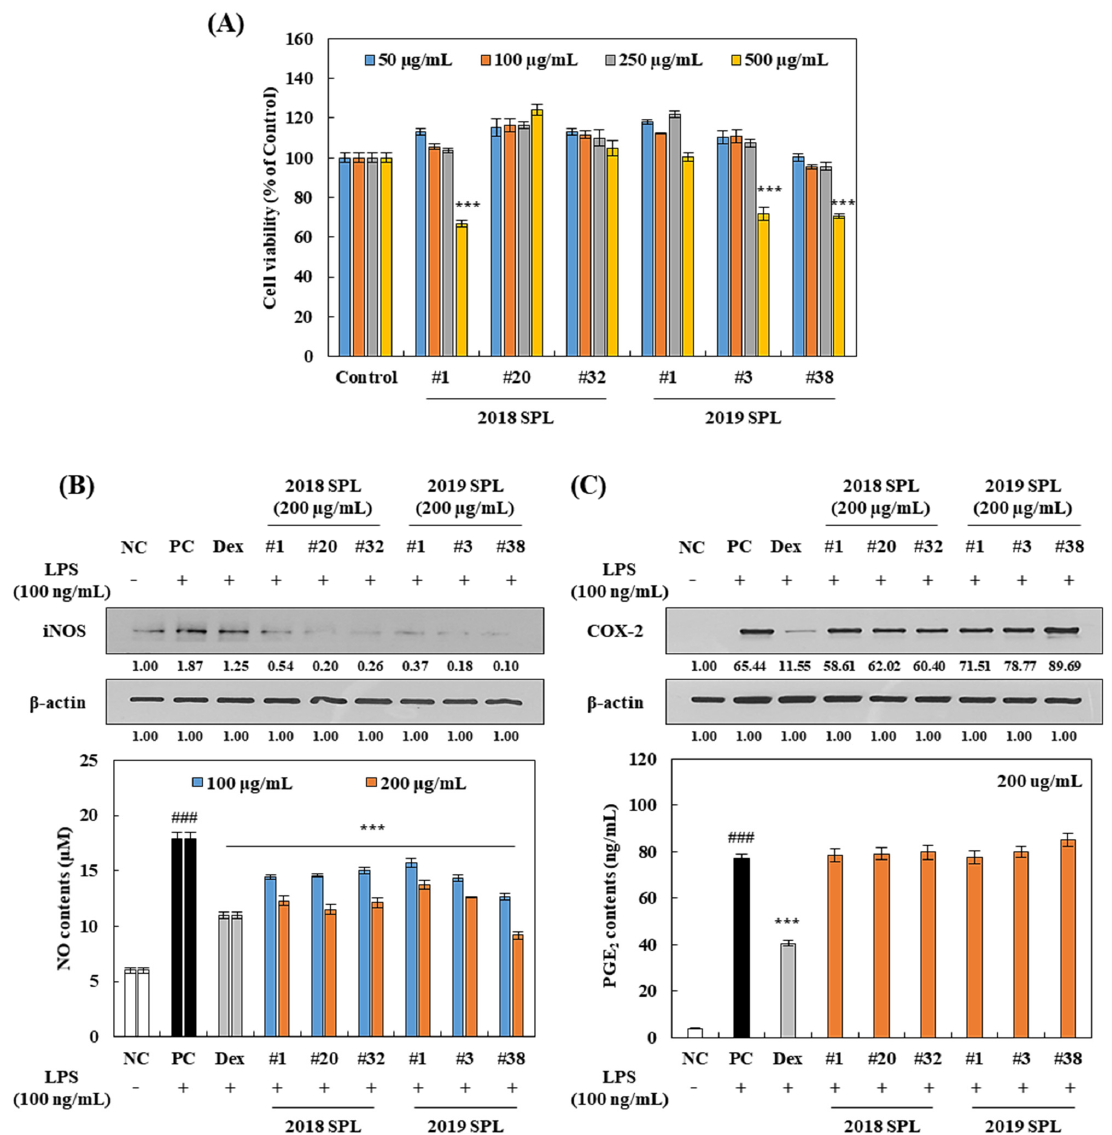
Figure 2. Effect of 2018 and 2019 SPL on LPS-induced NO and PGE 2 production in RAW 264.7 cells. Cells were treated with 50–500 μ g/mL of SPL for 24 h, and ( A ) cell viability was measured by MTS assay. ( B ) LPS-induced NO concentration was measured by Griess reagent system kit with NO standard, and iNOS expression was analyzed by Western blotting. ( C ) LPS-stimulated PGE 2 contents were identified by Prostaglandin E2 ELISA Kit, and COX-2 expression was analyzed by Western blotting. RAW 264.7 cells were pretreated 100–200 μ g/mL of SPL and 20 μ M of dexamethasone (Dex) for 2 h, and then cells were incubated with 100 ng/mL of LPS for 24 h (NO and PGE 2 contents analysis) and 12 h (Western blotting). Data are shown as mean ± SEM. Significant differences are compared with control at ### p < 0.01, and PC at *** p < 0.001 ( n = 9, cell viability; n = 9, NO contents; n = 8, PGE 2 contents).